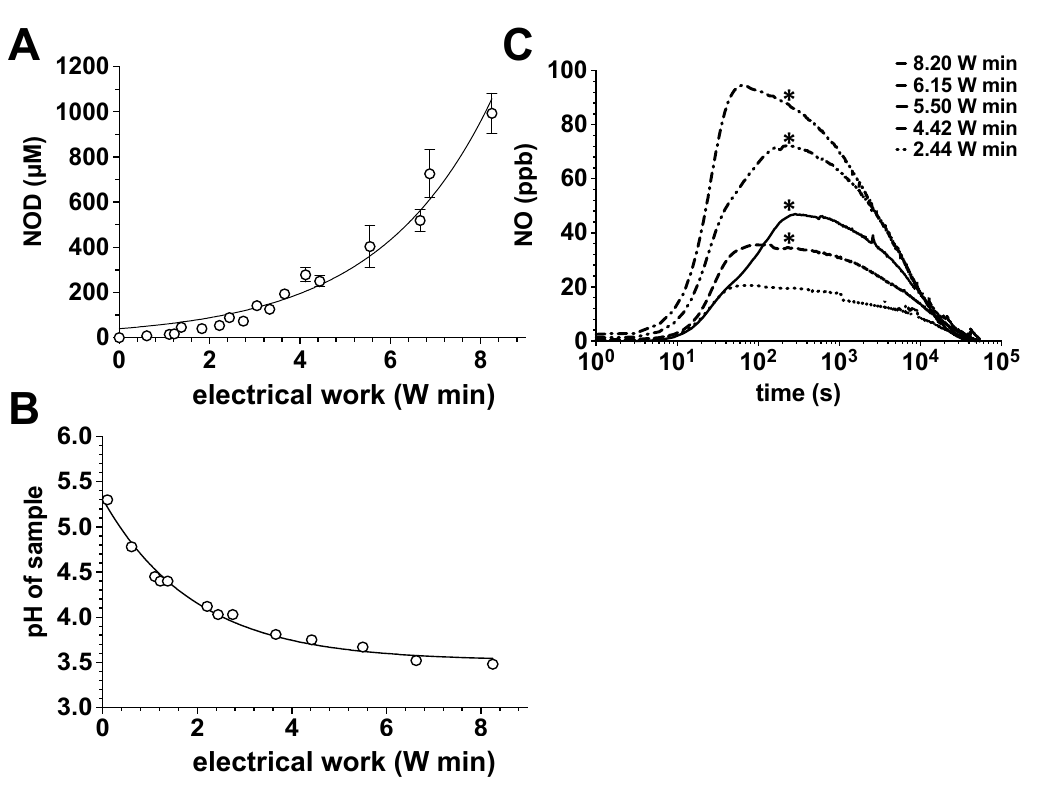
Figure 1. Impact of the power dissipation in the discharge on the pH, NOD accumulation and NO release in aqueous solutions exposed to the CAPs. Using the DBD plasma source, 20 mL of water samples were treated with CAPs generated with the power dissipated in the discharge of 122, 221, 275 or 410 mW for 5, 10, 15 or 20 min. The nitrite accumulation in the treated solutions was then quantified by CLD, the pH value of the solution was assessed with a pH meter and the course and the amount of NO release from these solutions was also characterized by CLD. ( A ) Nitrite content of the plasma ‐ treated samples as a function of the electrical work dissipated in the discharge. Open circles represent the mean ± S.D. of four individual experiments. ( B ) pH values of the plasma ‐ treated samples as a function of the electrical work dissipated in the discharge. ( C ) NO release from samples treated with plasma. A representative result of six individual tests is shown. *, p < 0.05, as compared to NO release from solutions treated with plasmas generated under conditions of less electrical work dissipated in the discharge.